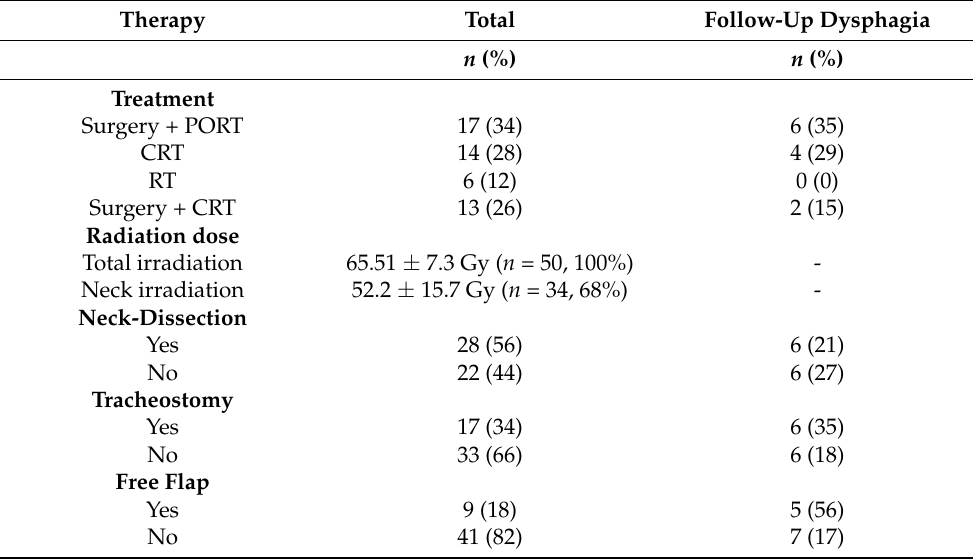
Table 2. Detailed Clinical Treatment of the Observed Study